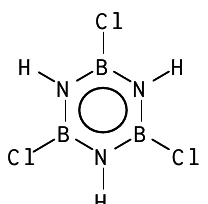
Figure 12. Structure of